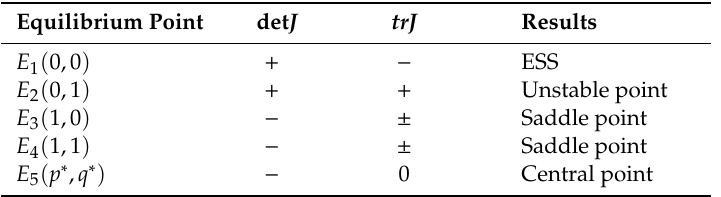
Table 6. The evolutionary stability of local equilibrium points in Case 3. Equilibrium Point